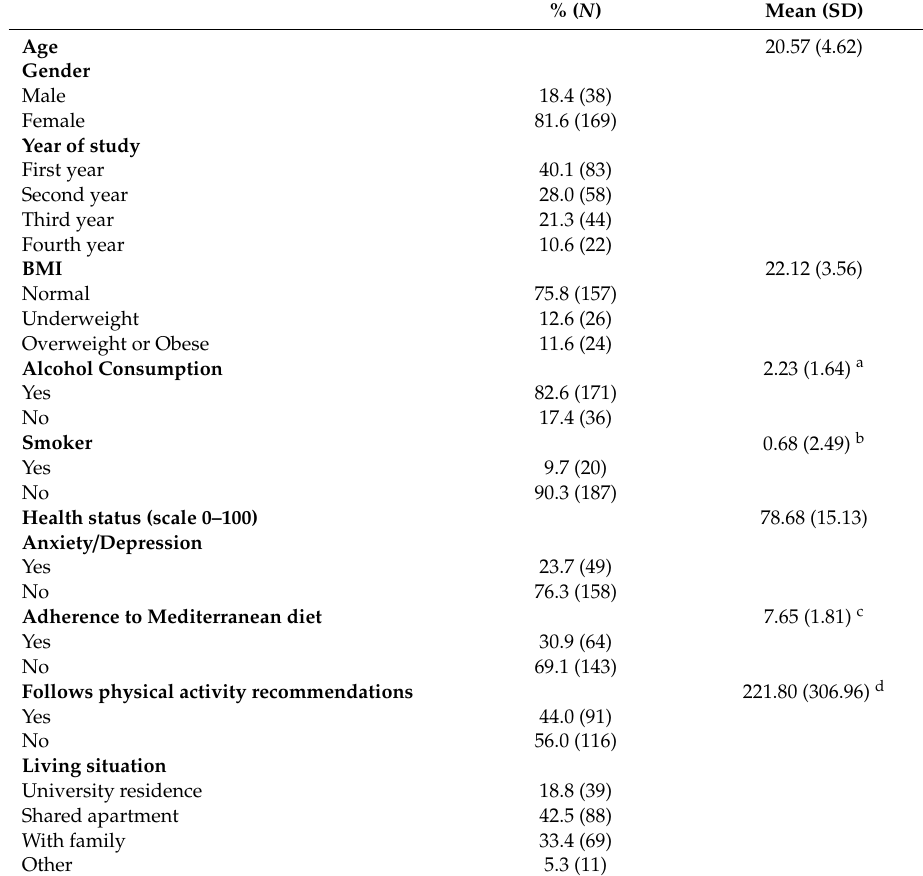
Table 1. Descriptive characteristics of the population.